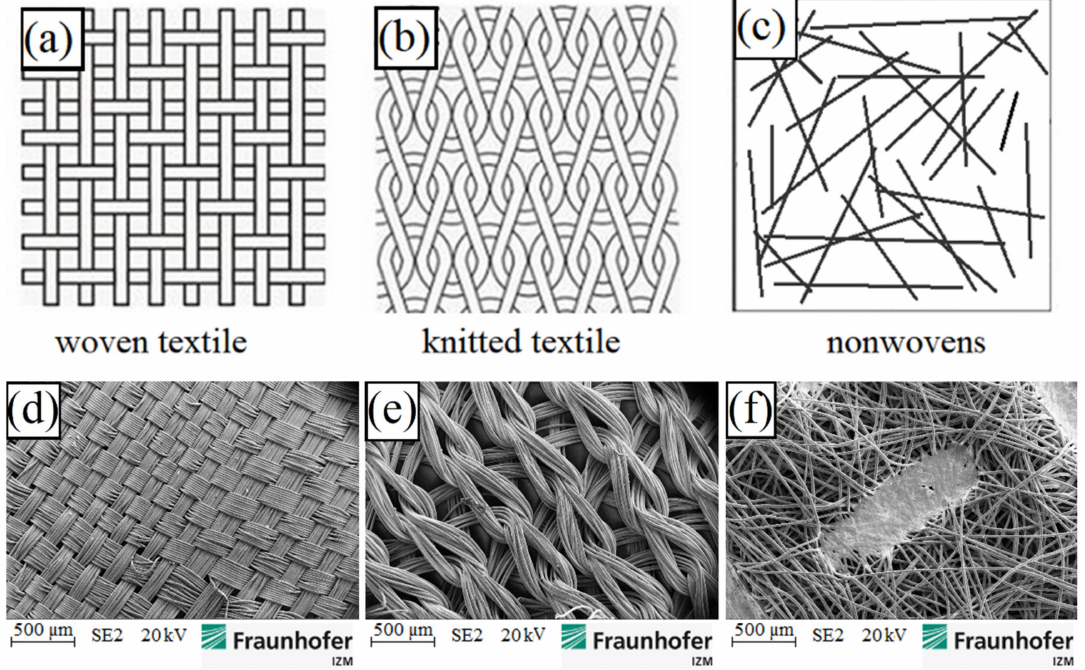
Figure 1. Schematic drawings above of: ( a ) woven; ( b ) knitted and ( c ) nonwoven fabrics and SEM images below of: ( d ) woven; ( e ) knitted and ( f ) nonwoven